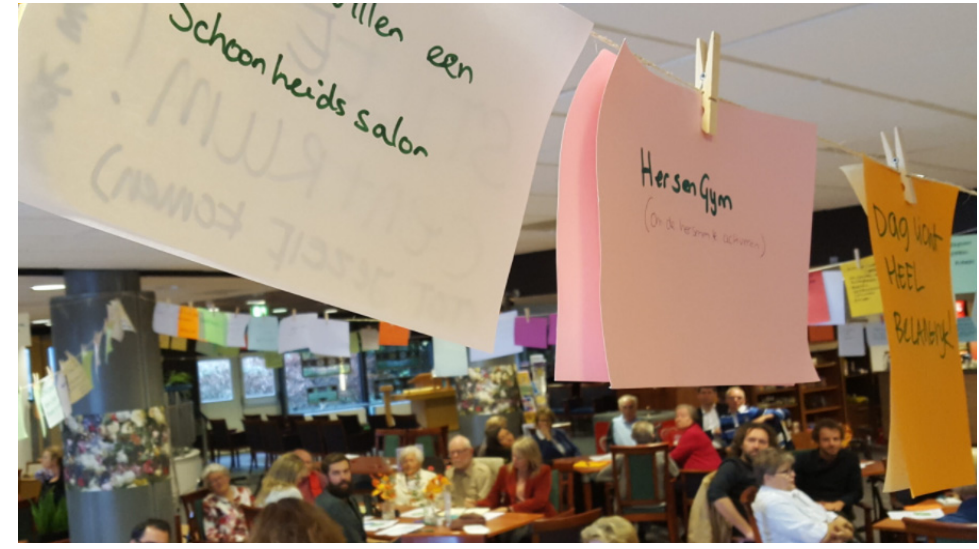
Figure 3. Example of participation in the concepting and design phase. Courtesy of Vastgoed zorgsector, Utrecht.